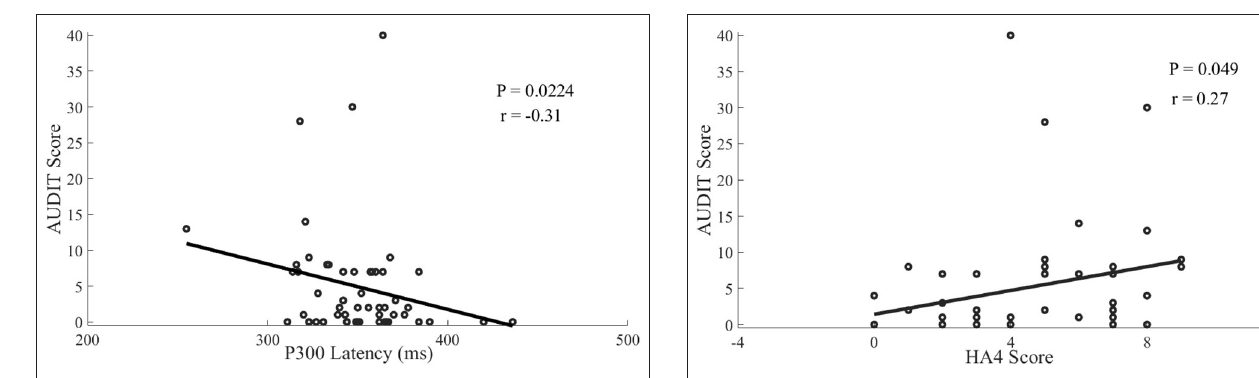
FIGURE 4 | Scatterplot of the correlation between AUDIT scores and HA4 Score among offspring of parents with alcohol